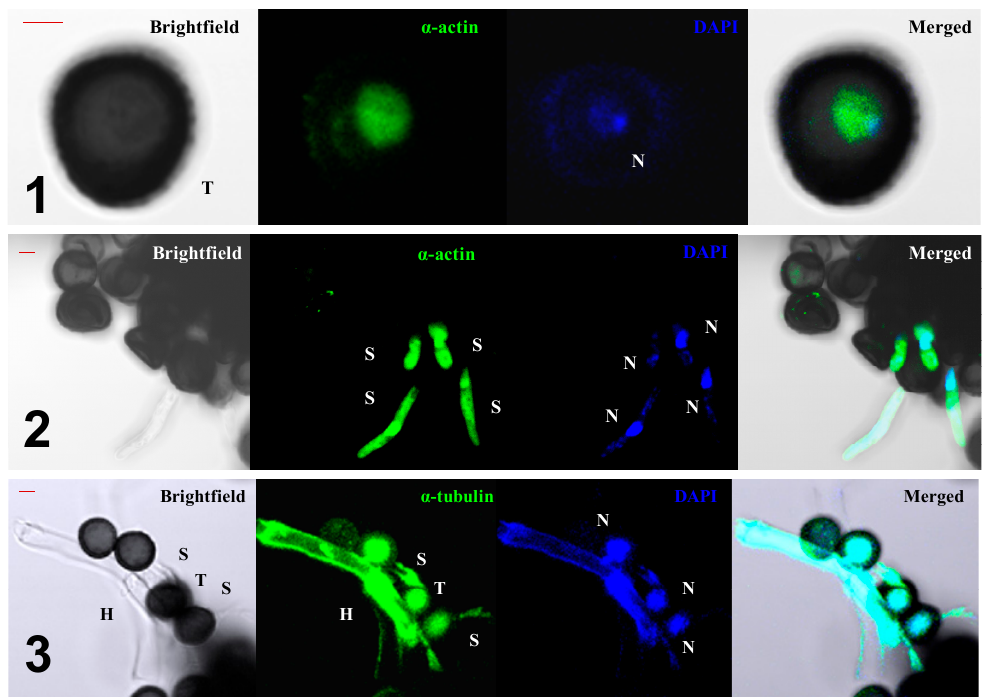
Figure 7. Confocal series (z-maxprojection) of cells. Brightfield, DAPI, α -actin images, as well as brightfield/DAPI/ α -actin composites, are shown in the 1 and 2 series. Brightfield, DAPI, α -tubulin images, as well as brightfield/DAPI/ α -tubulin composites, are shown in series number 3 (N—nucleus; H—hyphae; S—sporidia; T—teliospore). Scale bars indicate 2 µm.